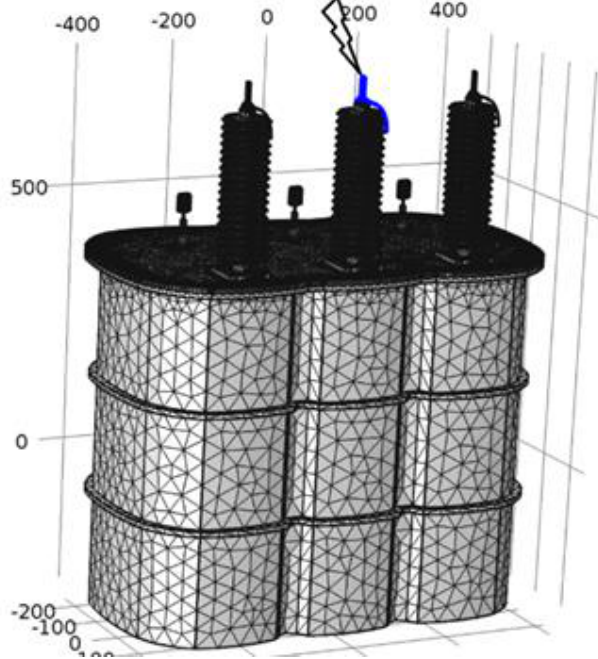
Figure 11. Potential distribution inside the tank in kV. Analysis of the lightning impulse voltage is shown in Figure 12.